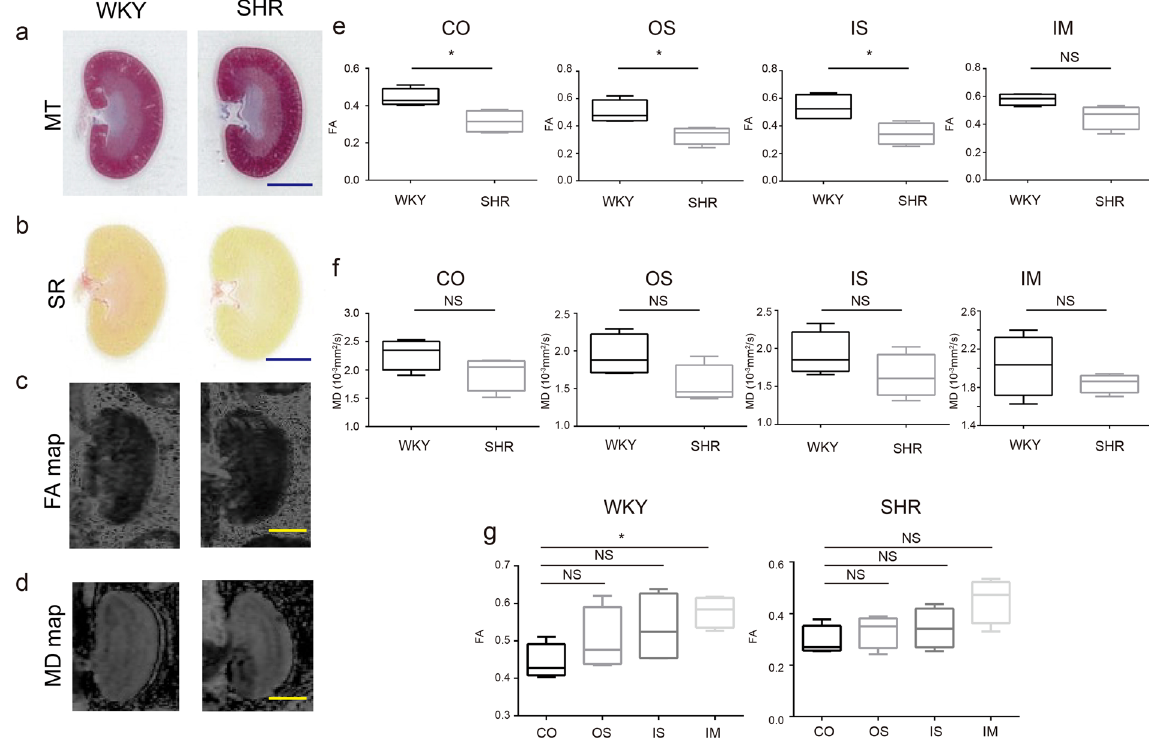
Figure 2. Analyses of FA and MD values in the kidneys of 8-week-old WKY and SHR/ND rats. ( a – d ) Masson trichrome (MT) ( a ), Sirius Red (SR) ( b ), FA map ( c ), and MD map ( d ) of WKY (left panel) and SHR/ND (right panel) rat kidneys. Scale bars, 5 mm. ( e , f ) Quantification of FA ( e ) and MD ( f ) values in the CO, OS of outer medulla, IS of outer medulla, and IM of WKY and SHR/ND rat kidneys. * p < 0.05, WKY vs SHR. ( g ) FA values in the same portions of WKY (left panel) and SHR/ND (right panel) rat kidneys. The data are shown as mean ± SD.